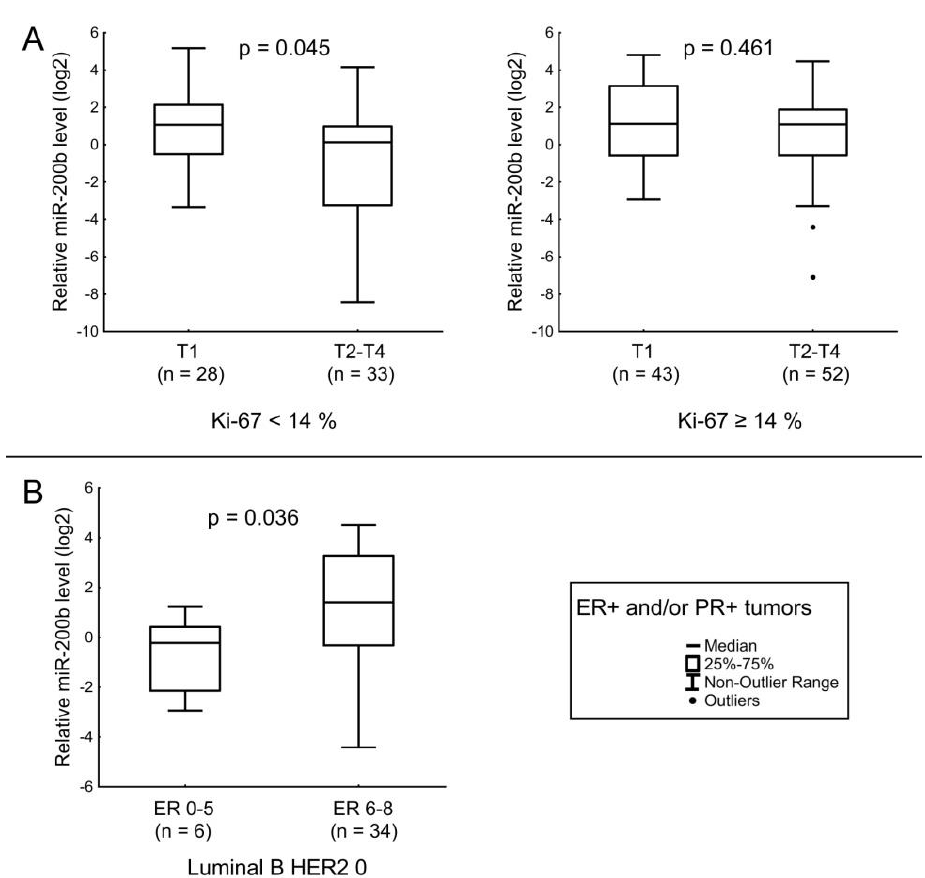
Figure 8. The comparison of miR-200b expression between different cancerous tissue groups: ( A ) relation of miR-200b level with the T stage in tumors with Ki-67 < 14% (left), relation of miR-200b level with the T stage in tumors with Ki-67 ≥ 14% (right); ( B ) relation of miR-200b level with ER expression level in luminal B HER2-non-expressing tumors. The Y axis presents the expression level (log 2 – ∆∆ Ct ); the results were normalized to the control (normal tissue). For miR-21, there was a tendency to an increase in its level in cases with LNM for patients with ER + and/or PR + HER2-expressing tumors with Ki-67 ≥ 14% (Figure 9A). In luminal B HER2-non-expressing tumors, the amount of miR-21 was significantly lower in the BC tissues of patients with PR IHC scores of 3–8 than in patients with IHC scores of 0–2 (Figure